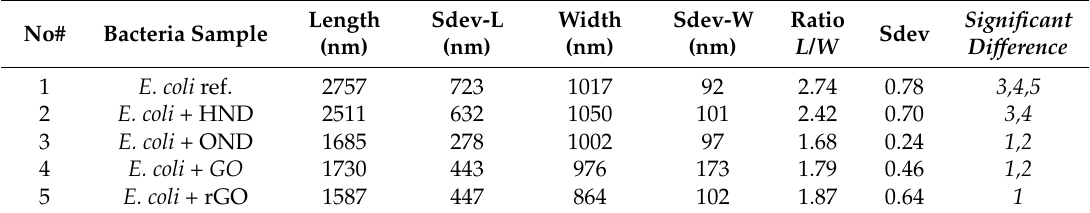
Table 1. Average length and width of E. coli as measured from sets of SEM images. The average ratio of length to width is also provided. The statistically significant difference ( α < 0.05) of the size ratio to other samples is indicated by sample numbers. Sdev denotes the standard deviation of the average